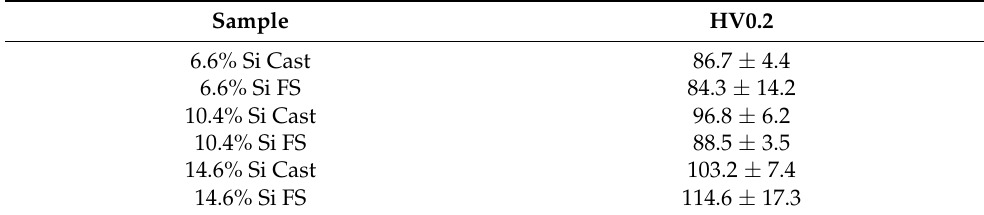
Table 2. Hardness of pin